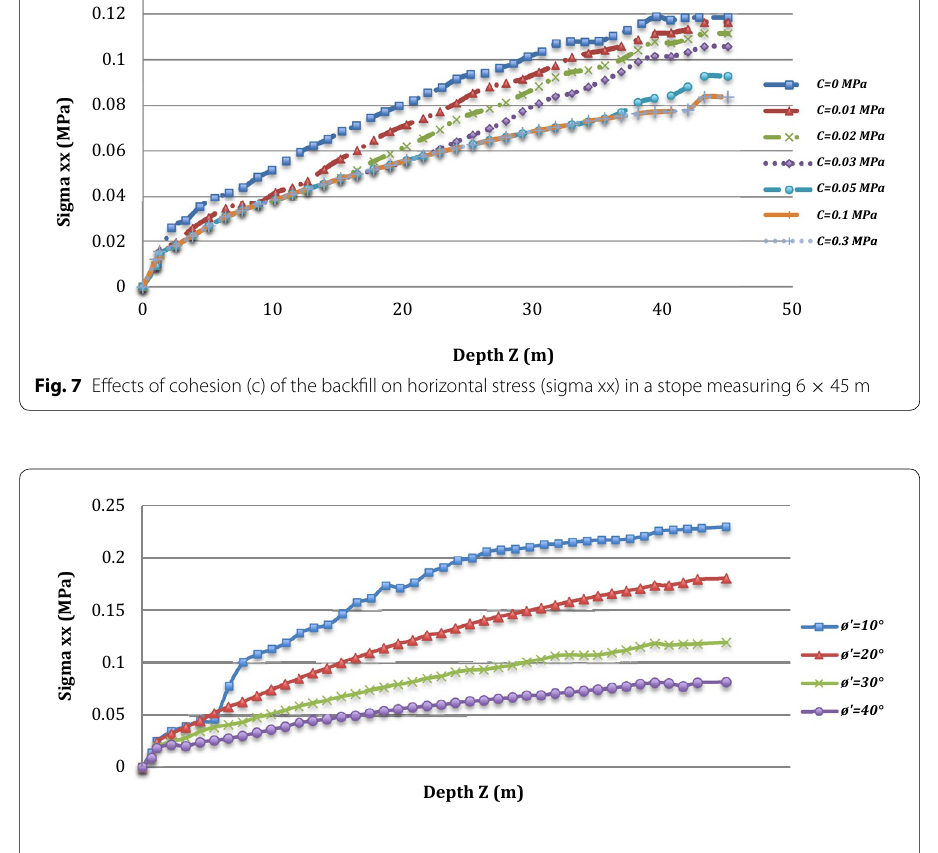
Fig. 8 Effects of the friction angle ( φ ′ ) of the backfill on horizontal stress (sigma xx) in a stope measuring 6 45 ×